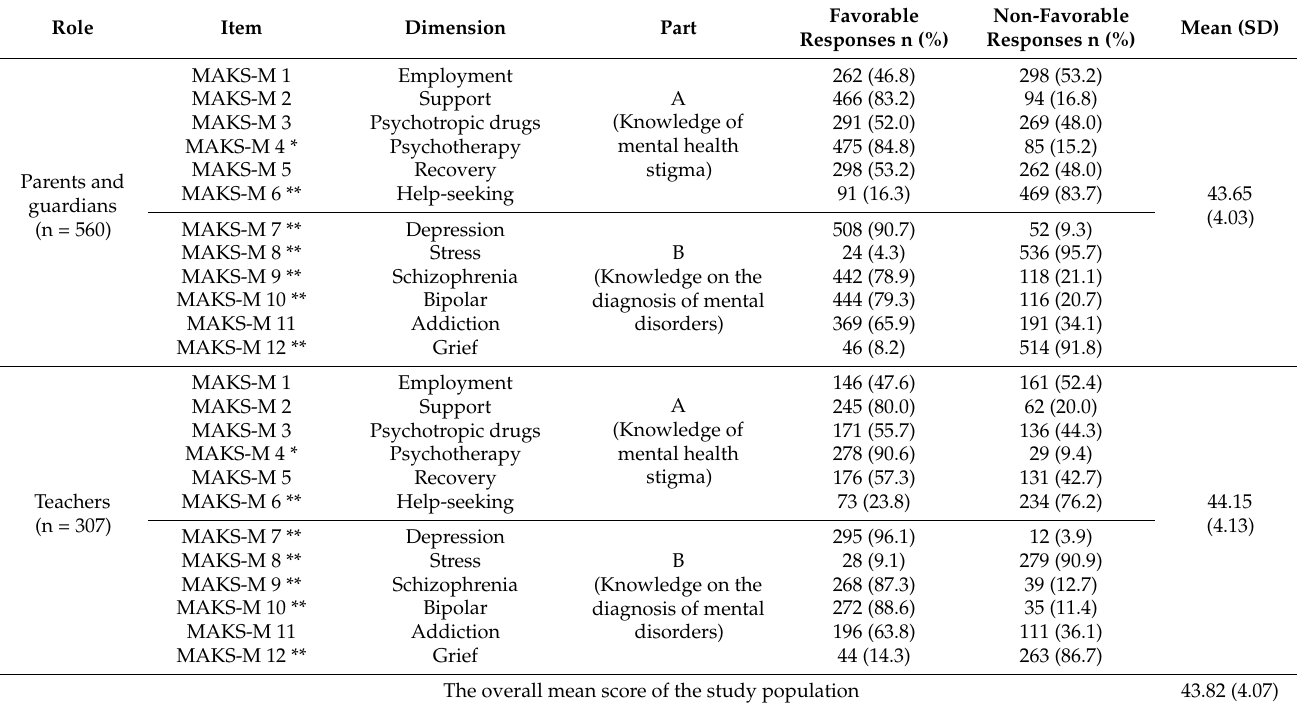
Table 2. Association between respondents’ roles and their responses based on favorable and non- favorable answers (n = 867).